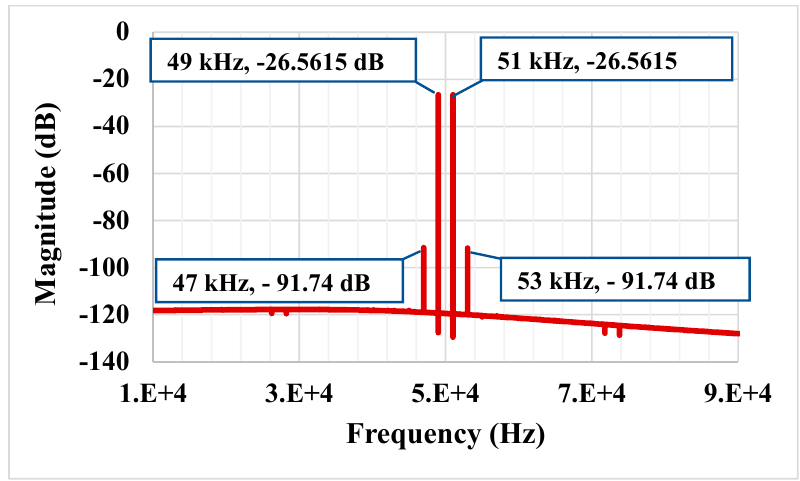
Figure 15. The process, voltage and temperature (PVT) corner analysis of the BP filter.